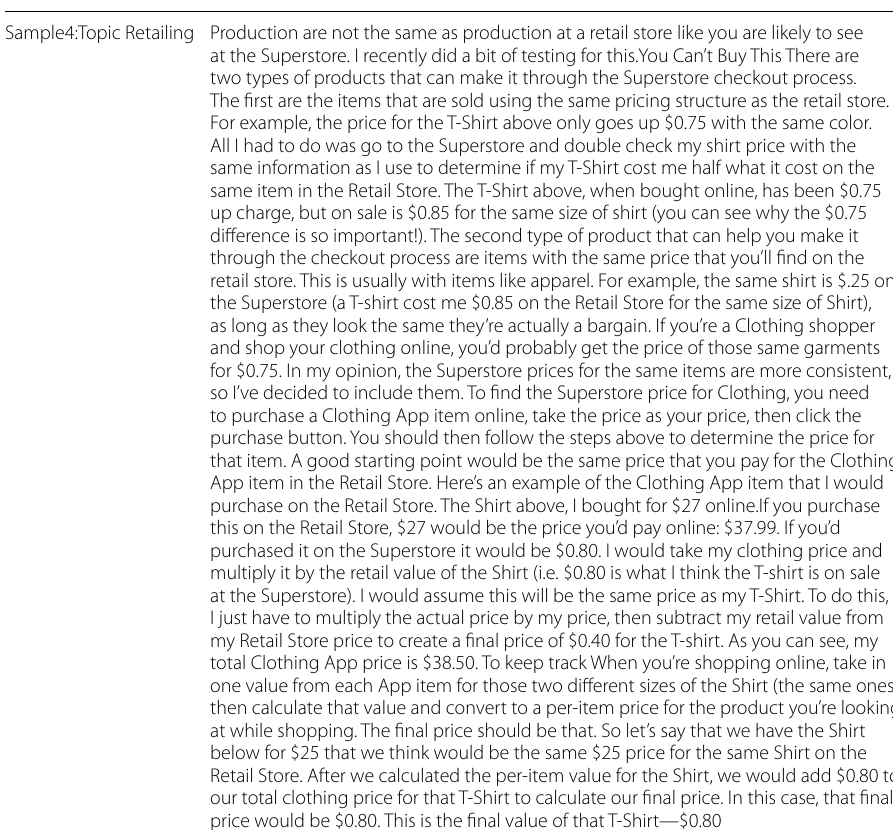
Table 10 Results of non-conditional samples Sample Machine generated